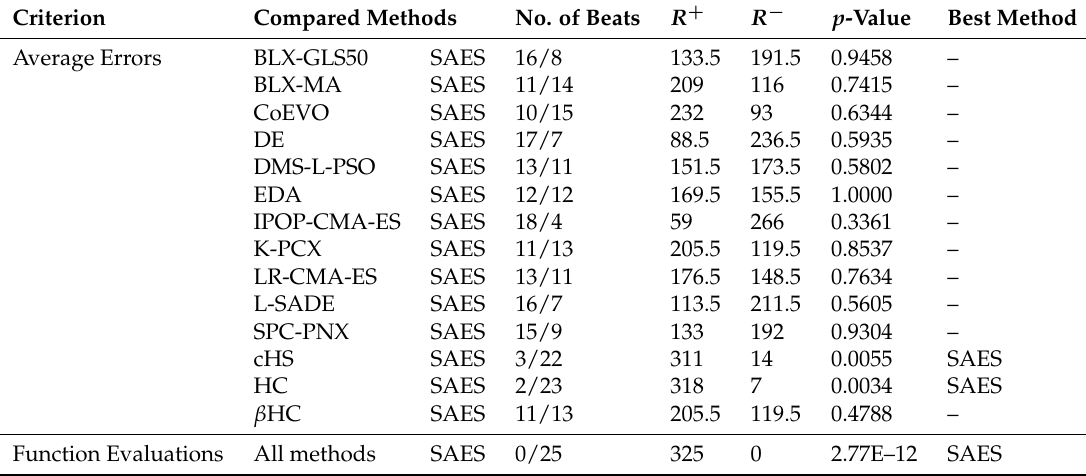
Table 8. Wilcoxon rank-sum test for the compared results in Table